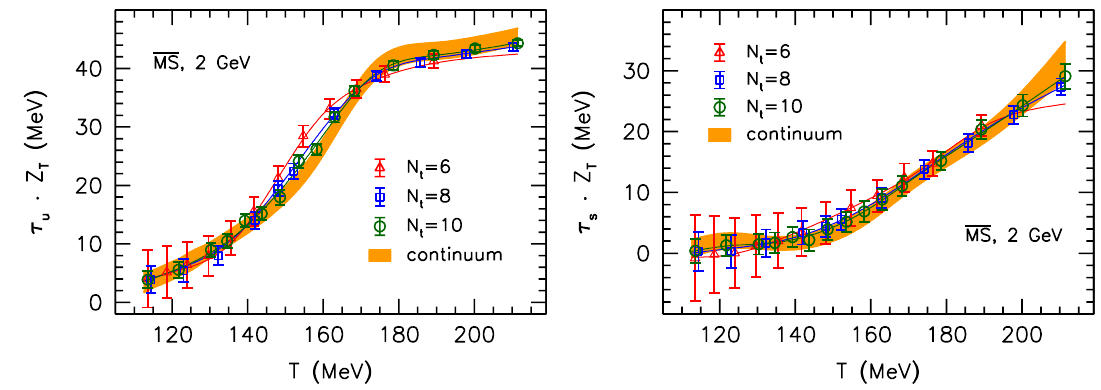
Figure 8 . Tensor coe(cid:14)cients after multiplicative as well as additive renormalization for the up (left panel) and for the strange quark (right